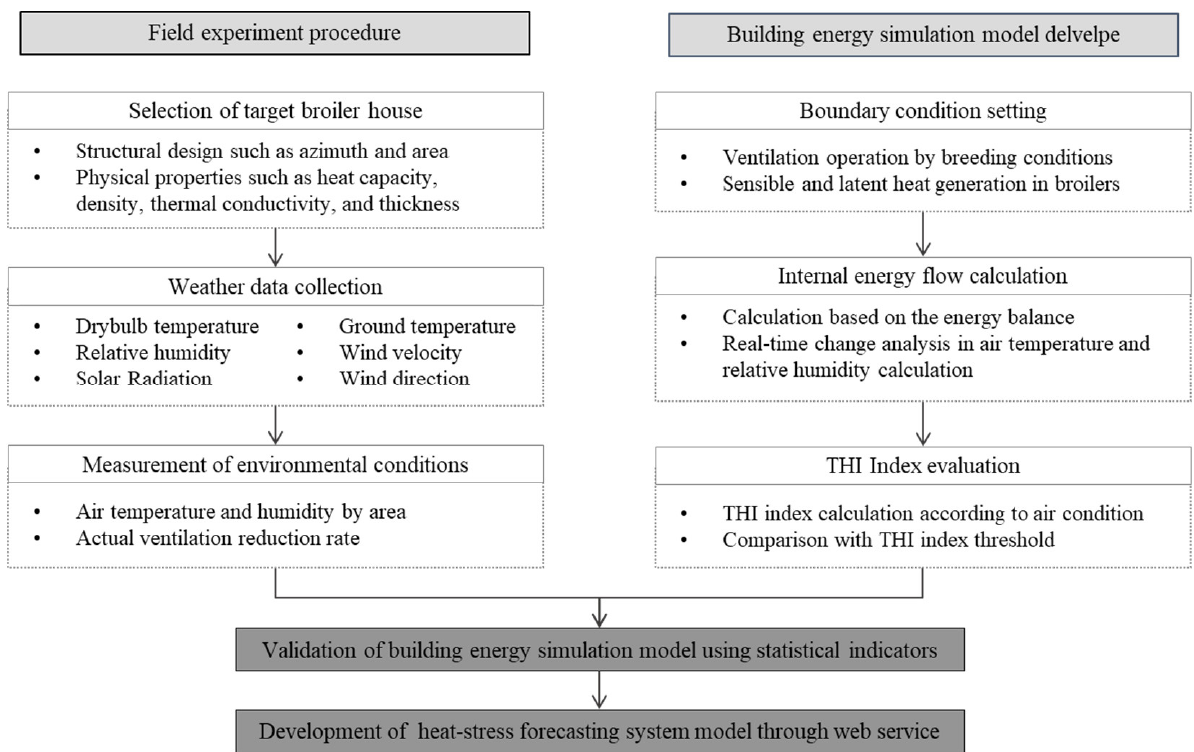
Figure 5. Research flow for heat stress energy model development procedure.